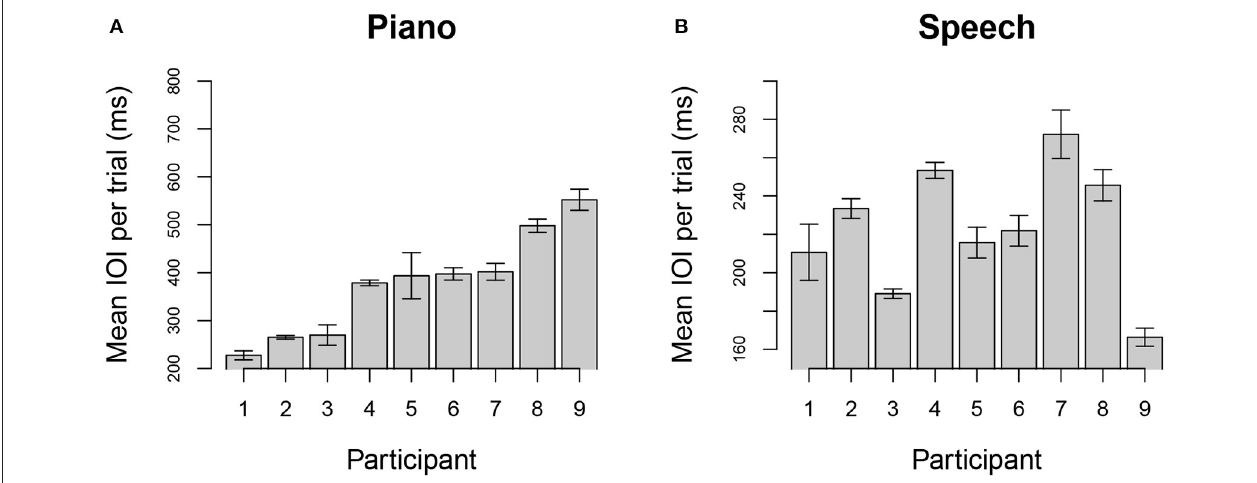
FIGURE 5 | Mean IOI (SE) of spontaneous rates by individual for melodies (A) and speech (B) . Units are expressed in milliseconds, and participants are ordered in both graphs from fastest to slowest spontaneous rates in the music task. Note that y-axis limits vary to show range of individual differences. Participant #8 was the French L1 participant.